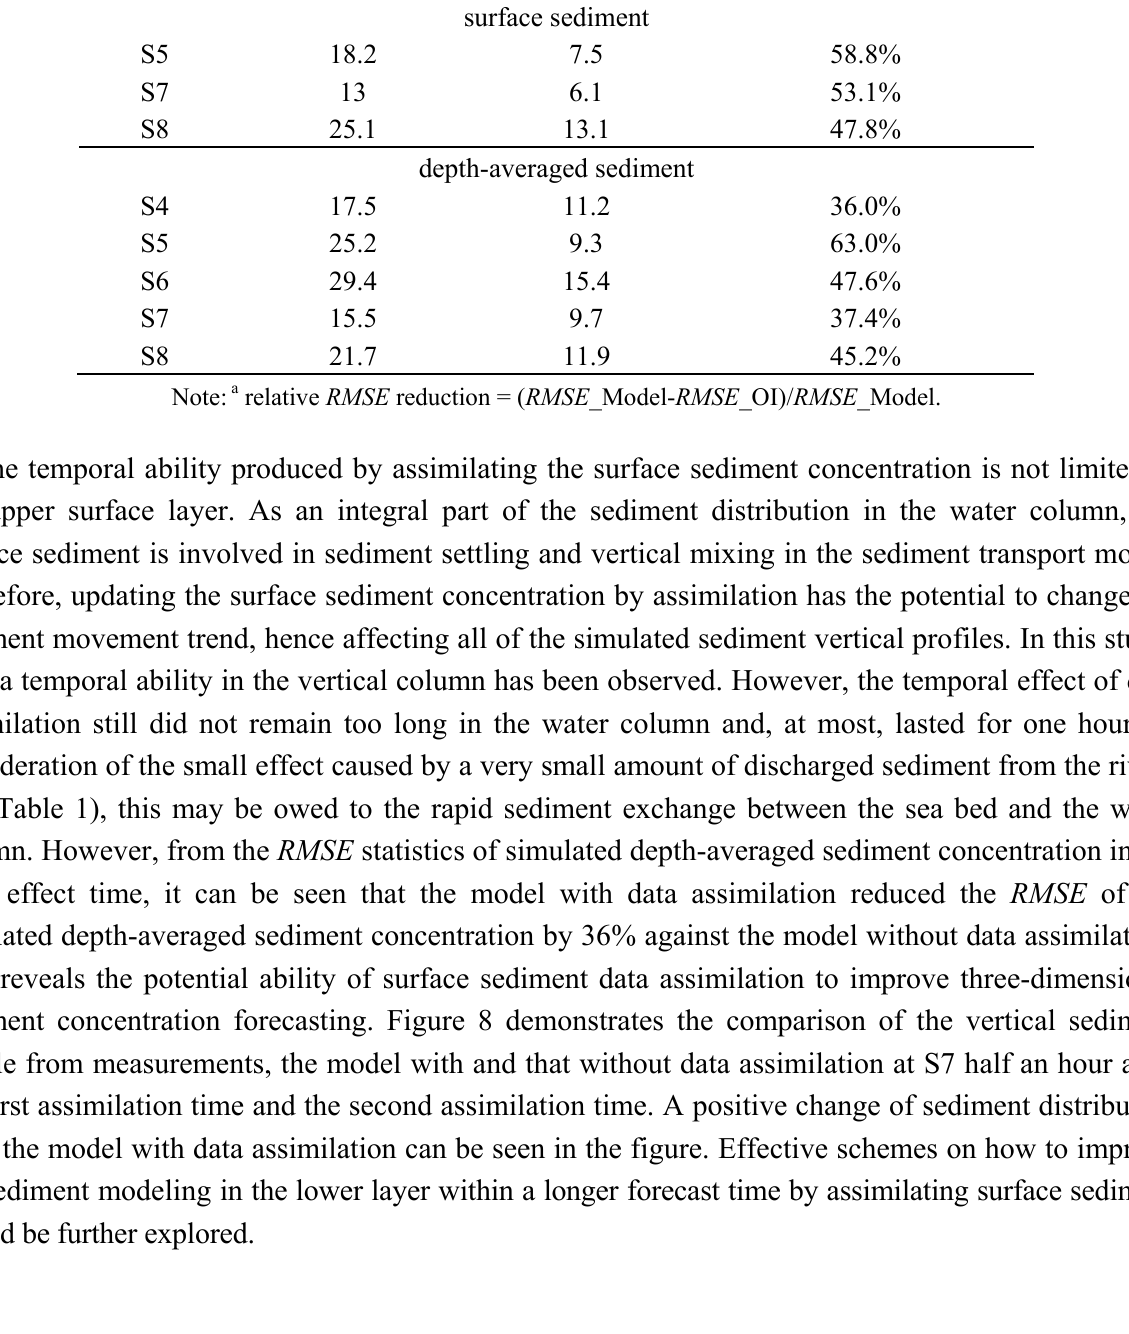
Sites Model without OI Model with